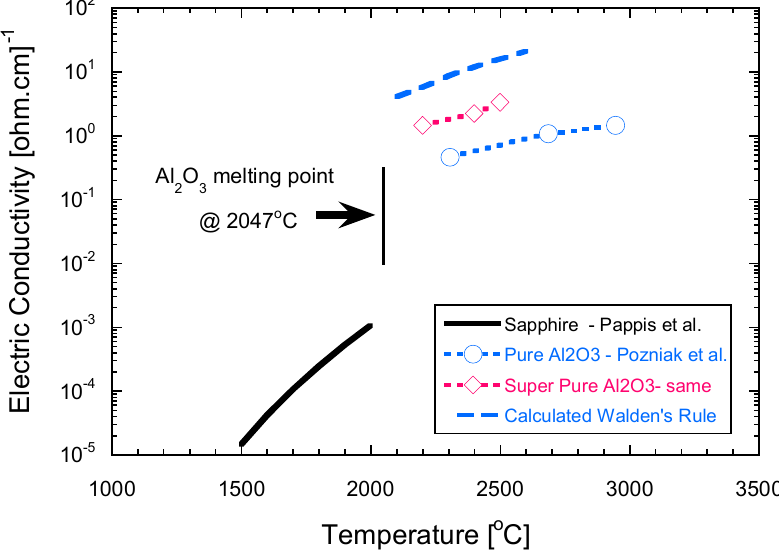
Figure 1. Electric conductivity of Sapphire crystal (black solid line) and alumina melt (blue dashed line) calculated from Walden’s rule. The measured experimental values for pure (blue open circles) and super-pure alumina (red open diamonds) melts presented for comparison. Melting leads to increase in the electric conductivity by two to four orders of magnitude.